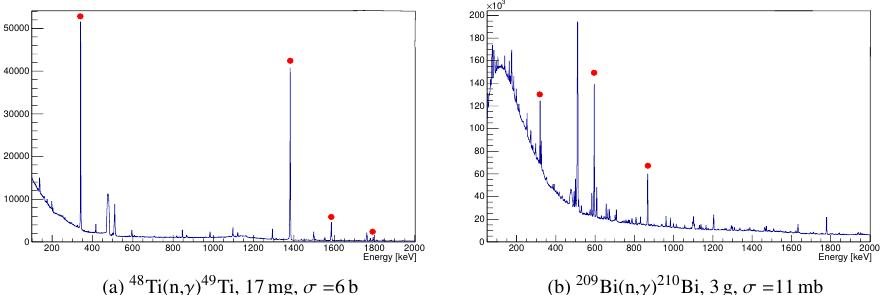
Figure 3: Examples of FIPPS spectra. Some of the main γ -ray lines belonging to the produced isotopes are labeled with red